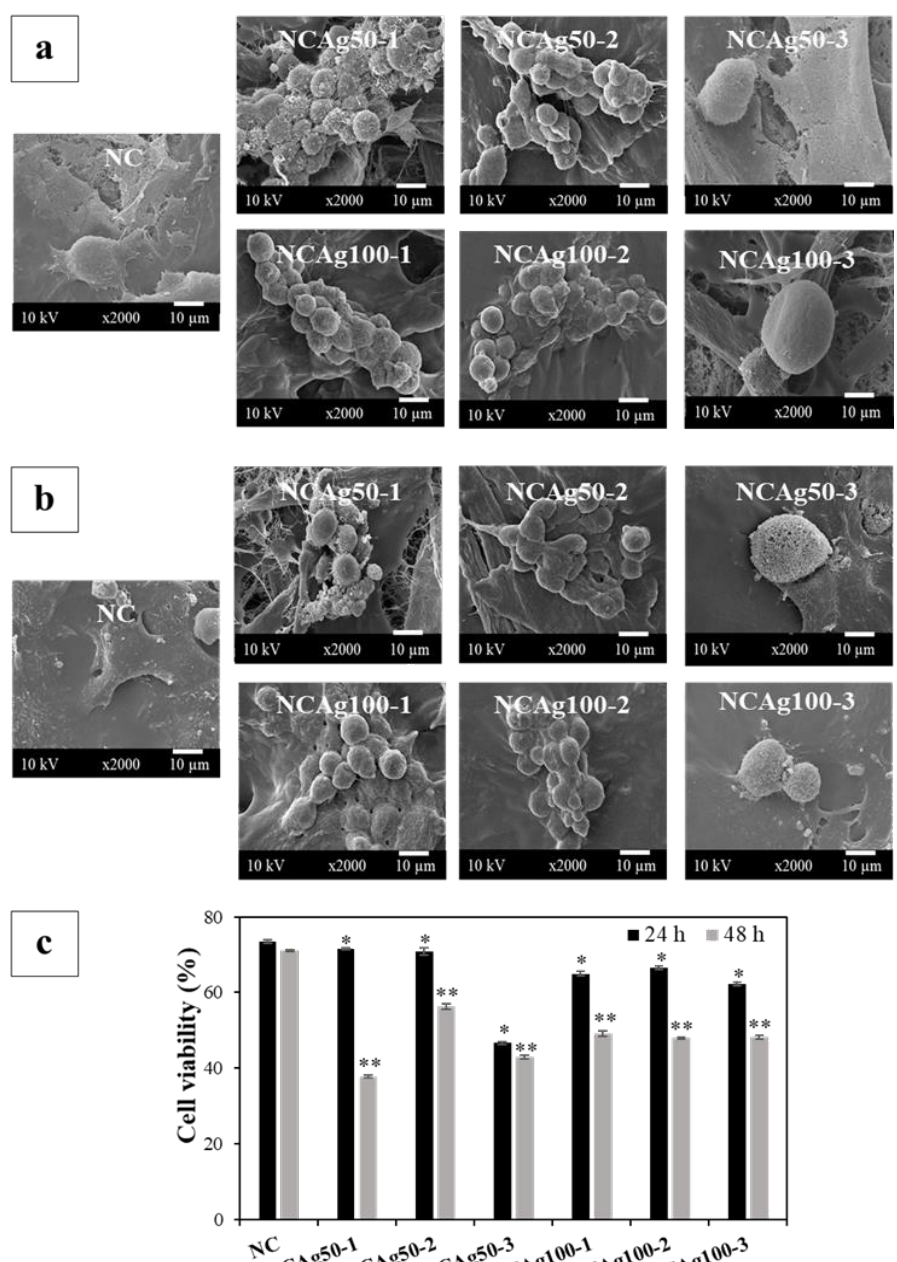
Figure 10. Morphology of HaCaT cells cultured on NC and NCAg composite films for 24 h ( a ) and 48 h ( b ). Cell viability was quantified ( c ) at 24 h ( ◼ ) and 48 h ( ◼ ). The viability was normalized by the viability of cells cultured on tissue culture plate, which was expressed as 100% viability. The symbols * and ** indicate a significant difference ( p > 0.05, n = 3) vs. NC at 24 and 48 h, respectively.